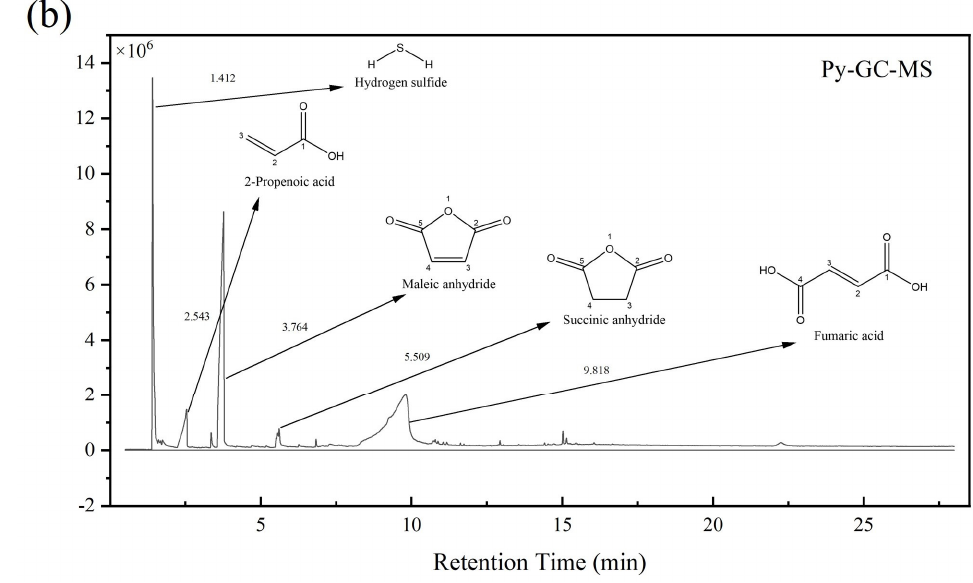
Figure 5. Chromatograms of FAS: ( a ) GC-MS; ( b ) Py-GC-MS. Table 4. Volatiles in FAS retrieved by computer.